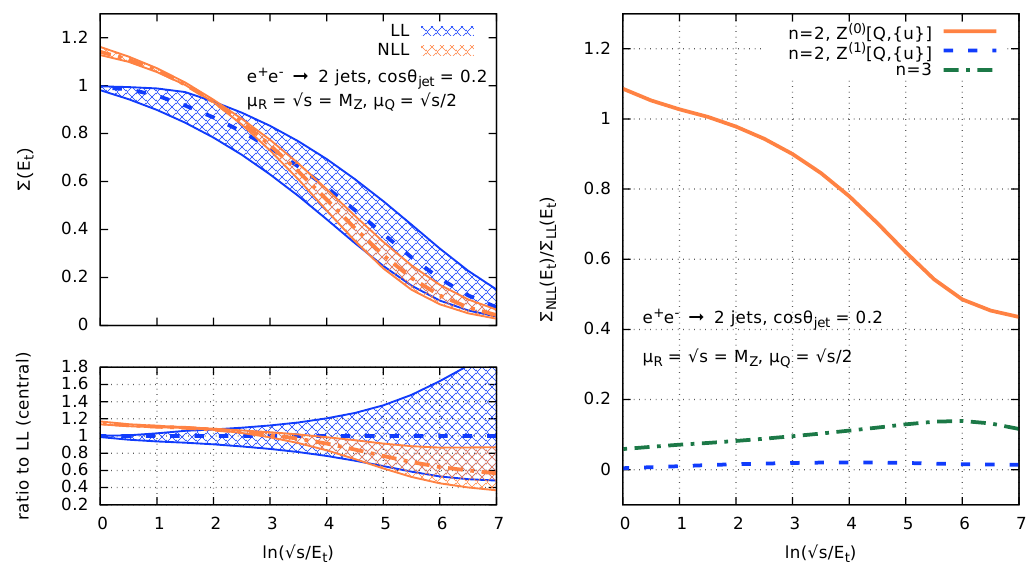
Figure 3 . Left: cumulative distribution Σ( E t ) for the transverse energy in the interjet rapidity gap at LL and NLL for c = 0 . 2 . Right: breakdown of the contributions to the NLL correction, relative to the LL